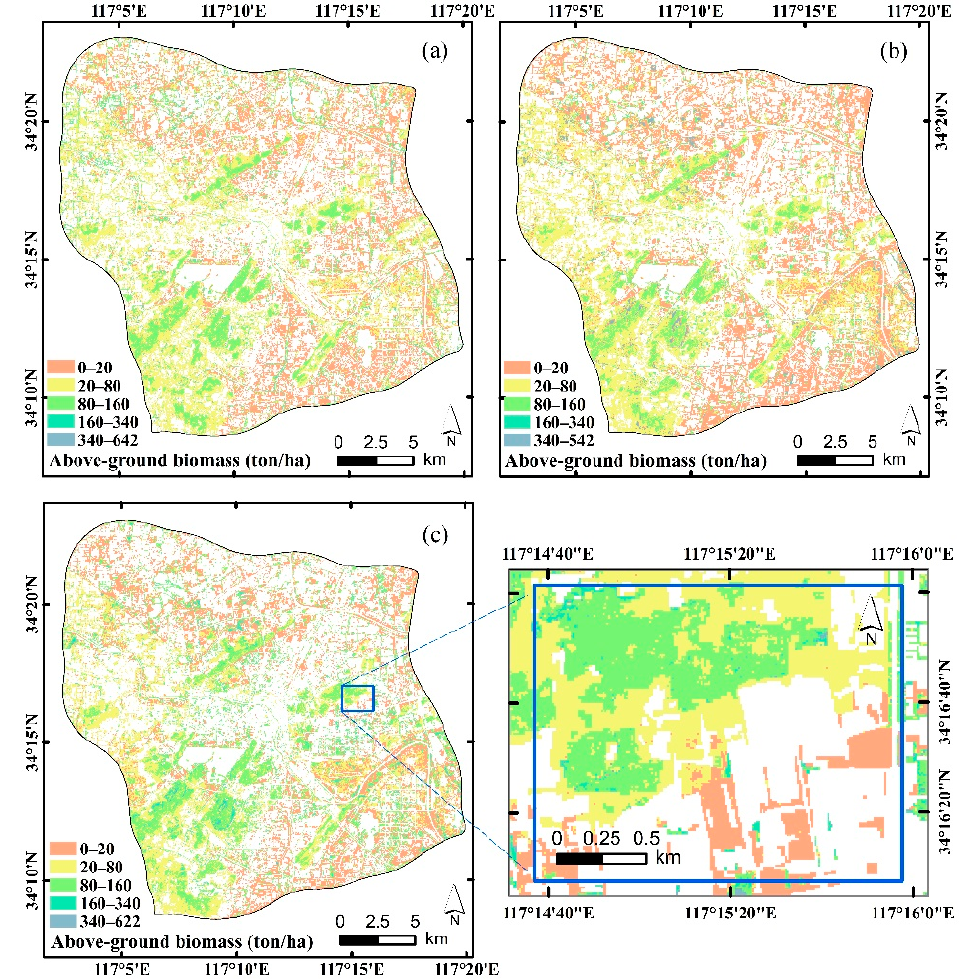
Figure 8. AGB values of UGS in Xuzhou: ( a ) 28 August 2016; ( b ) 14 June 2018; ( c ) 23 June 2021.